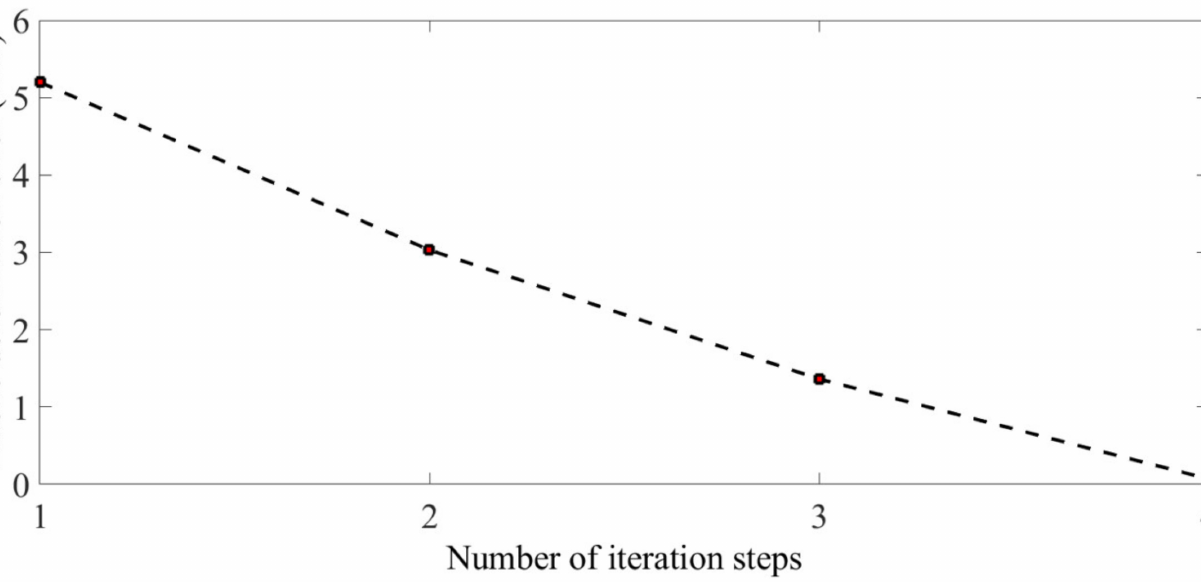
Figure 21. Elastic deformation